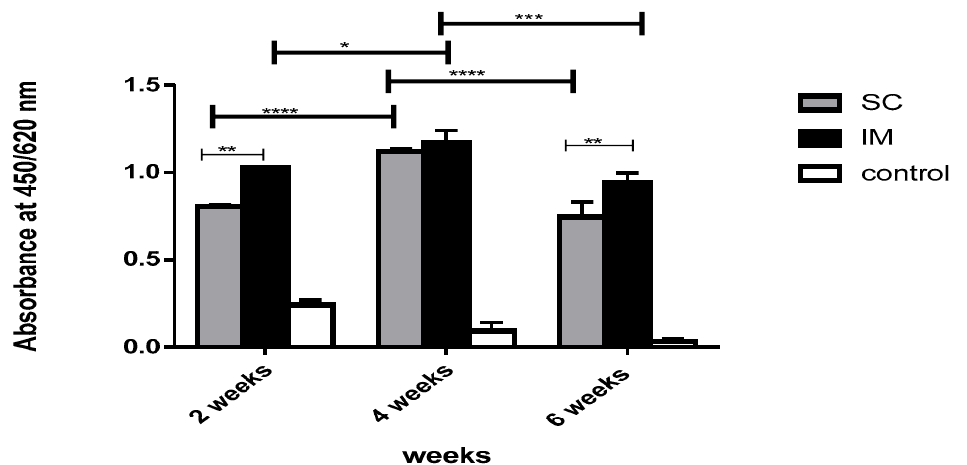
Figure 6. Immune response of SC route versus IM route after immunization with meningococcal (walvax) vaccine. A bar chart showing antibody response in rats measured in terms of absorbance values in weeks 2, 4, and 6 after immunization with the commercial meningococcal vaccine against PBS (control) through subcutaneous (SC) and intramuscular (IM) immunization routes. Error bars represent the standard deviation from the mean. * Indicates significance with p < 0.05, ** indicates significance with p < 0.01, *** indicates significance with p < 0.001, and **** indicates significance with p < 0.0001.